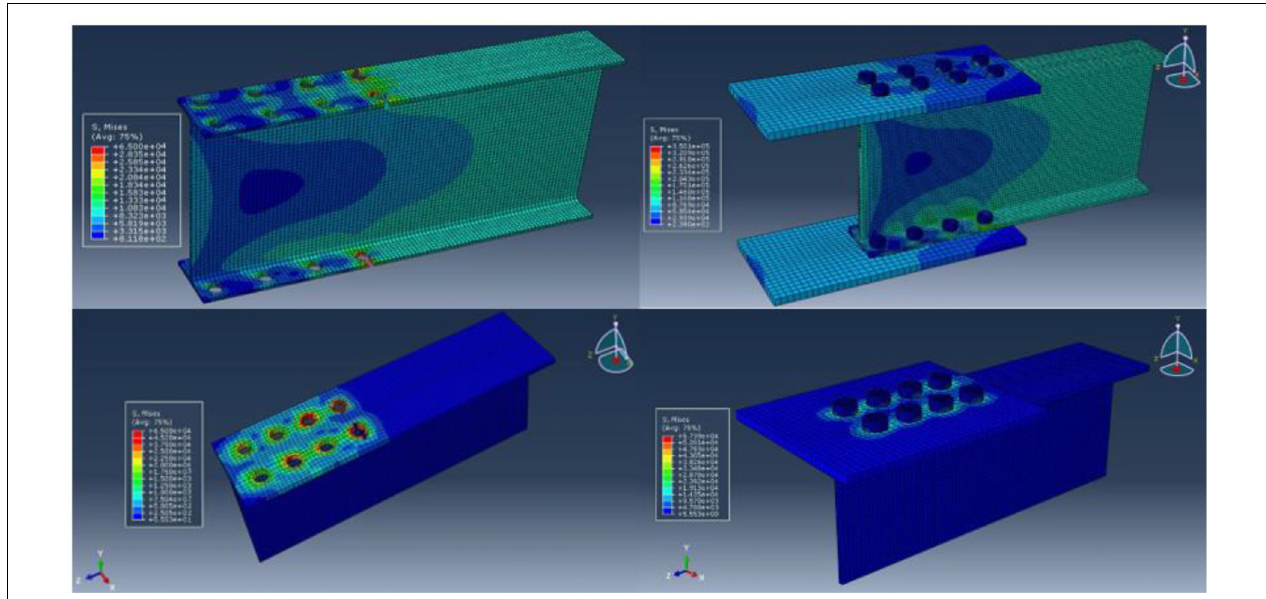
FIGURE 2 | Sample meshing and stress contours generated from the